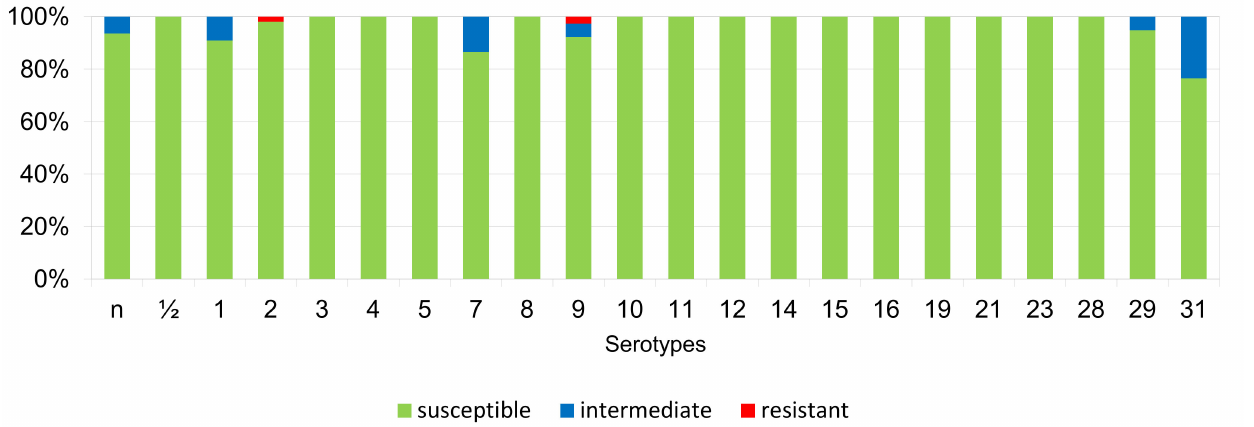
Figure 8. Percentage representation of isolates resistant, intermediately resistant, and susceptible to florfenicol belonging to individual S. suis serotypes from the Czech Republic during 2018–2022 ( n = 506). n = non-typeable